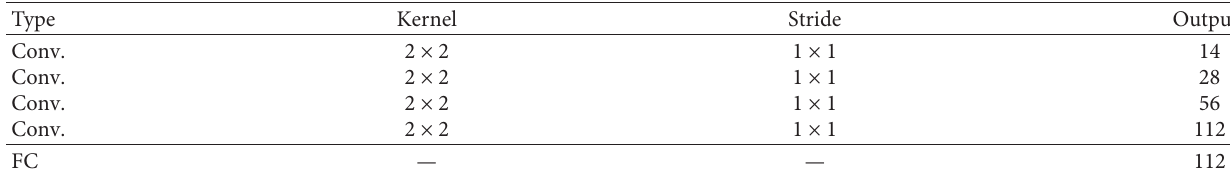
Table 4: Architecture of local discriminator.